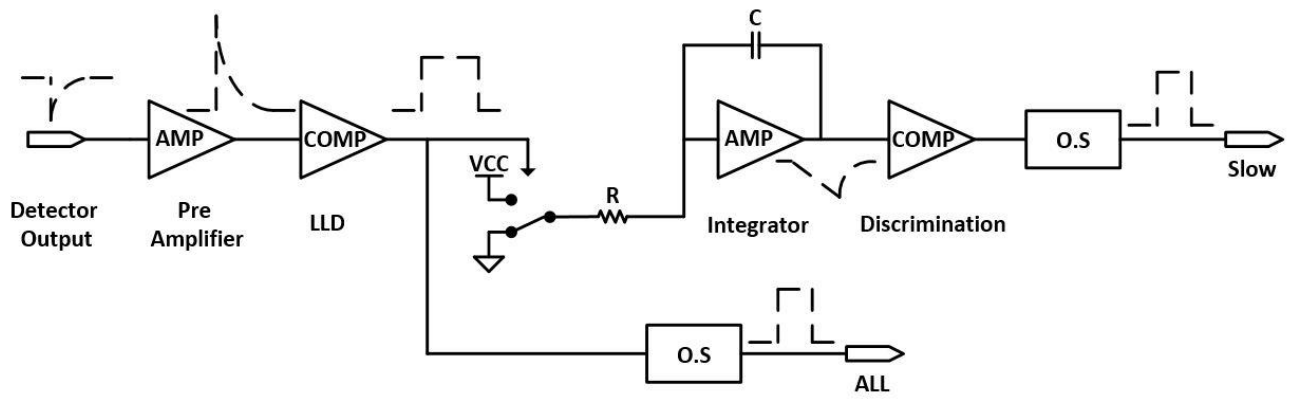
Fig. 3. Scheme of the proposed time based discrimination topology.